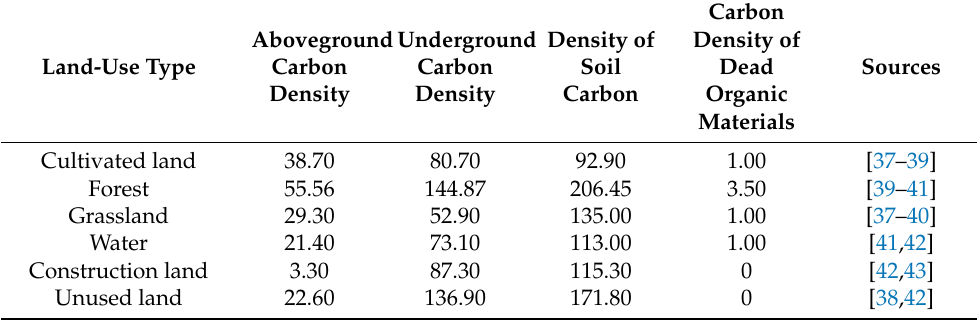
Table 4. Carbon density based on land-use/cover type included in the InVEST model (t/ha).